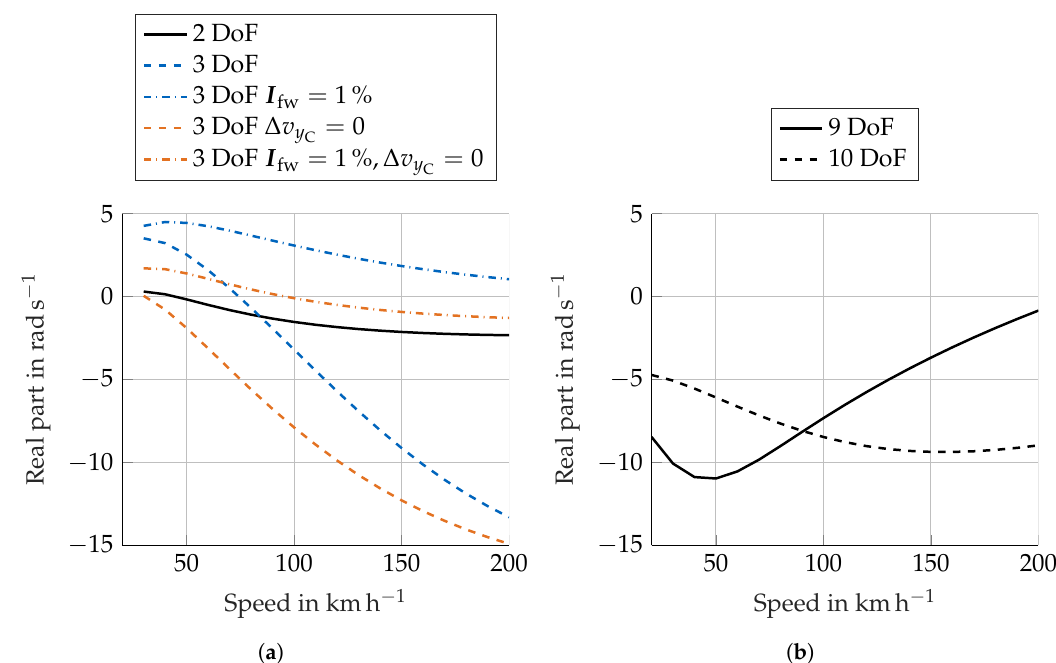
Figure 8. ( a ) Wobble damping for the 2 and 3-DoF models with variation of the tensor I fw and compensation of ∆ v y . The curve with I fw = 1% for the 2-DoF model is identical to that with C I fw = 100% so it was not plotted. ( b ) Figure 4b copied to facilitate the